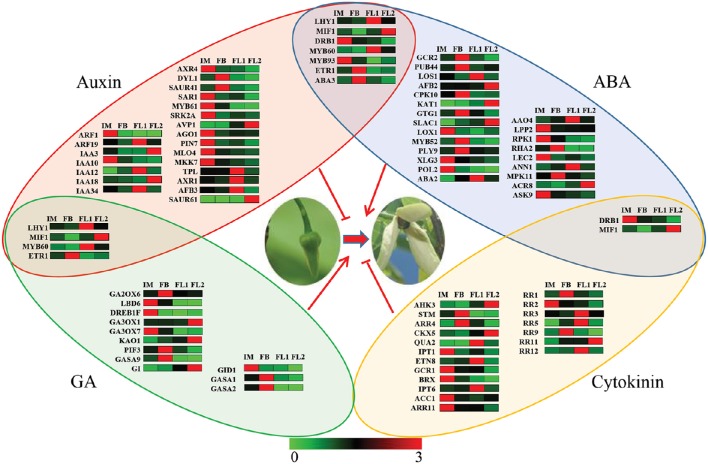
Network analysis of various hormones involved in the regulation of flowering process. The red shadow color indicated the key genes associated with auxin signaling pathway. The blue shadow color indicated the key genes with ABA signaling pathway. The green shadow color indicated the key genes with GA signaling pathway. The yellow shadow color indicated the key genes with cytokinin signaling pathway. The different colors correspond to the log-transcription values of RPKM refer to each gene shown in the bar at the bottom of the figure.